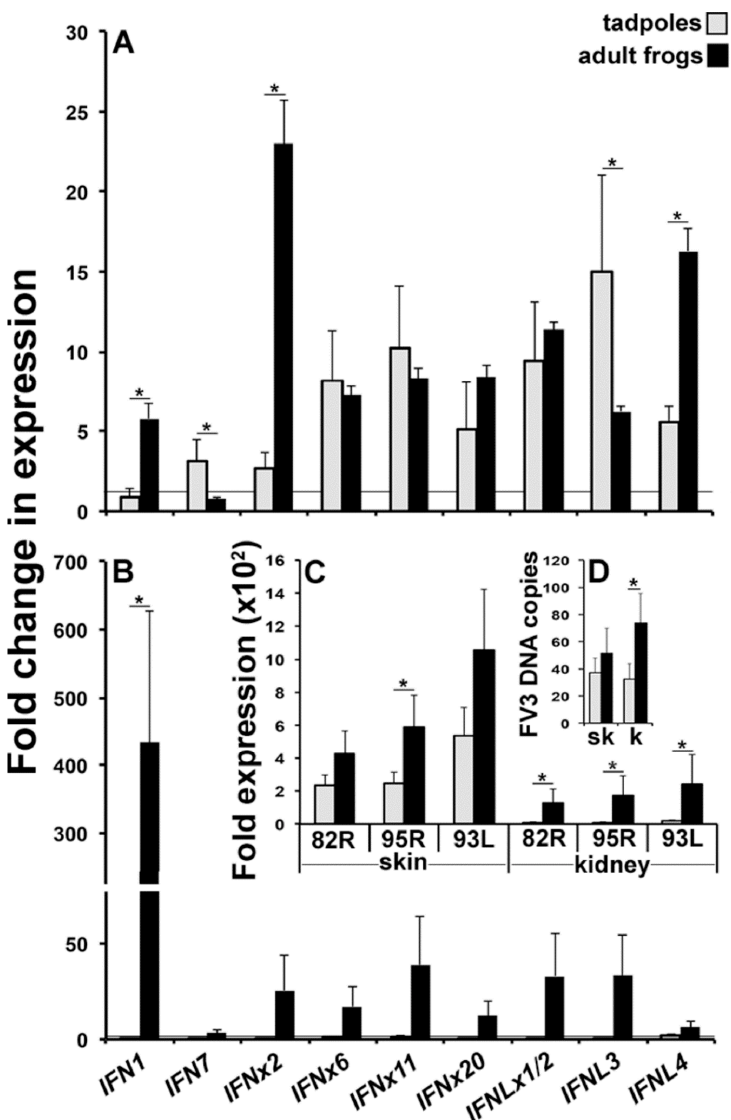
Figure 4. Tadpoles and adult frog kidney cells mount distinct IFN responses following FV3 infections. Tadpoles (NF 54, N = 5) and adult frog (1 year old, N = 5) skin cells were isolated and infected with FV3 (0.5 MOI) for 6 h, and were examined for skin ( A ) and ( B ) kidney cell expressions of IFN genes as well as ( C ) skin and kidney cell expressions of FV3 genes and their ( D ) FV3 DNA loads. All of the gene expressions were compared to the GAPDH control, normalized against the mock-infected expression of the respective genes within given tissues. All of the results are presented as means + SEM. Significant differences between the respective experimental groups are denoted by overhead lines and asterisks (*). p < 0.05.